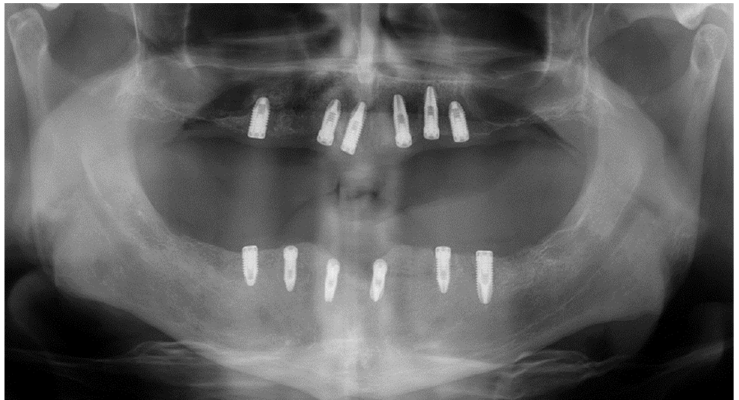
Figure 5. Immediate dental implants in both the maxilla and mandible for functional rehabilitation after teeth extraction.